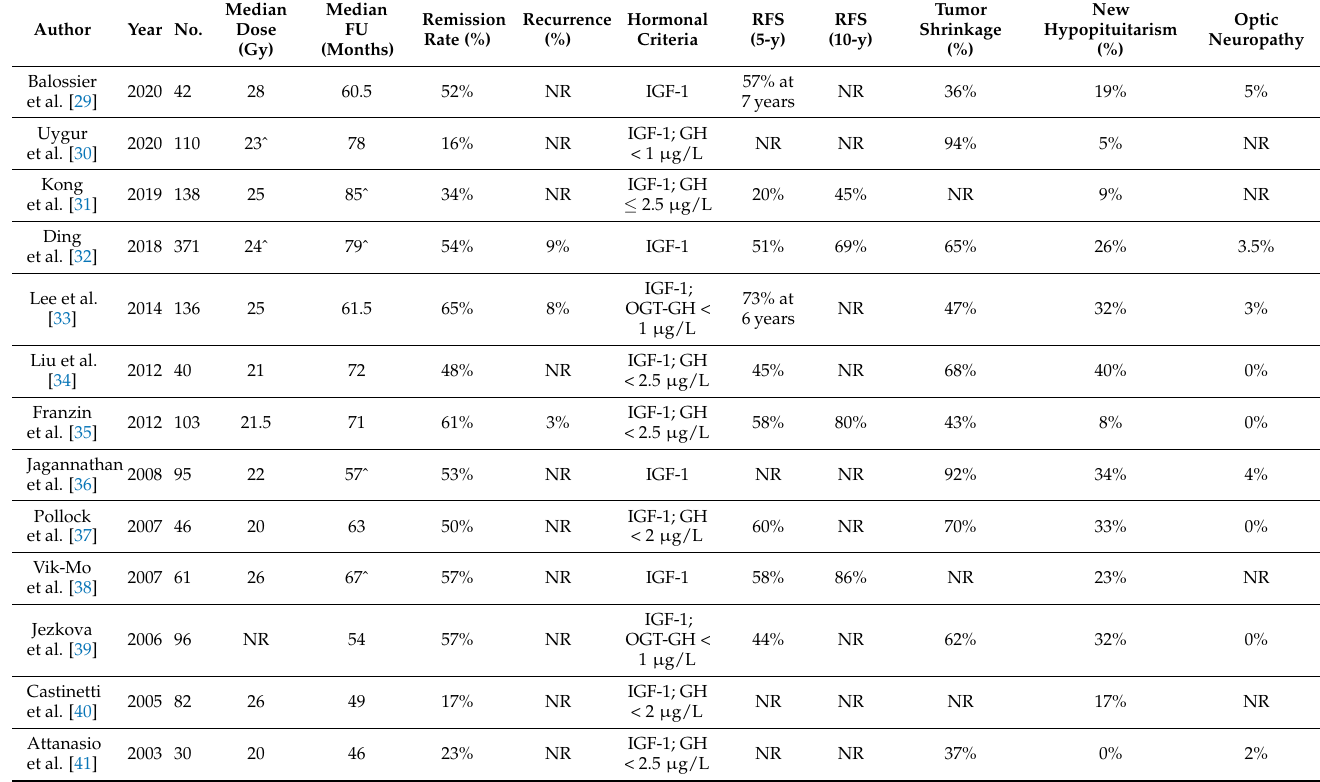
Table 2. GH-secreting pituitary adenoma Gamma Knife treatment outcomes and